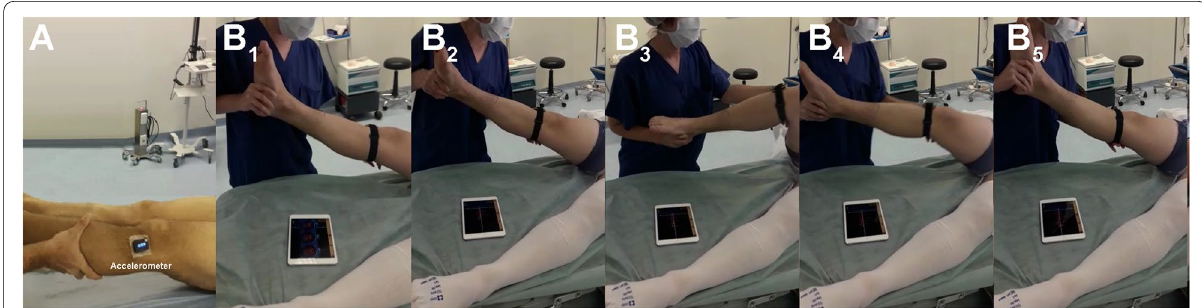
Fig. 1 Intra-operative pivot-shift maneuver before surgery. A Sensor orientation. B1 to B5 The sequence of the pivot-shift